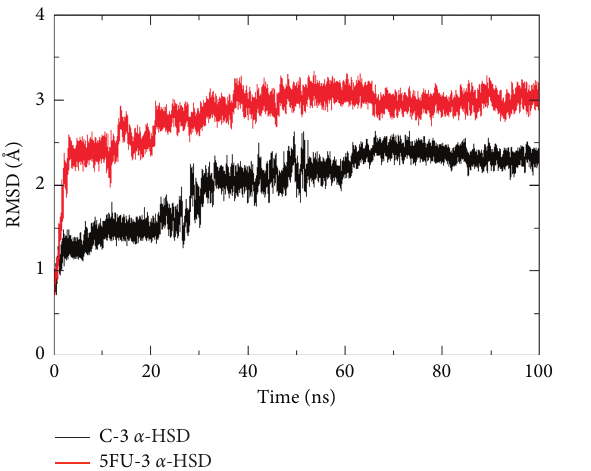
Figure 6: RMSF plots of compounds C -3 α -HSD (black) and 5FU - 3 α -HSD (red) complexes during the 100ns MD simulations.